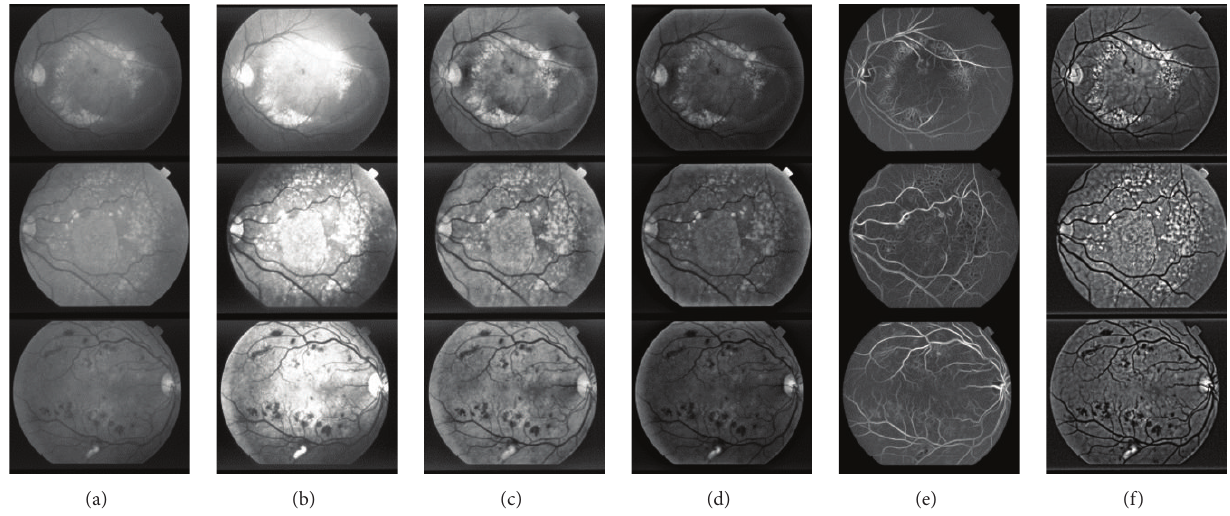
Figure 9: The comparison of image enhancement results of three images in the STARE database. (a) The original image; (b) the enhancement results of HE; (c) the enhancement results of CLAHE; (d) the enhancement results using method in [7]; (e) the enhancement results using method in [9]; (f) the enhancement results of the proposed